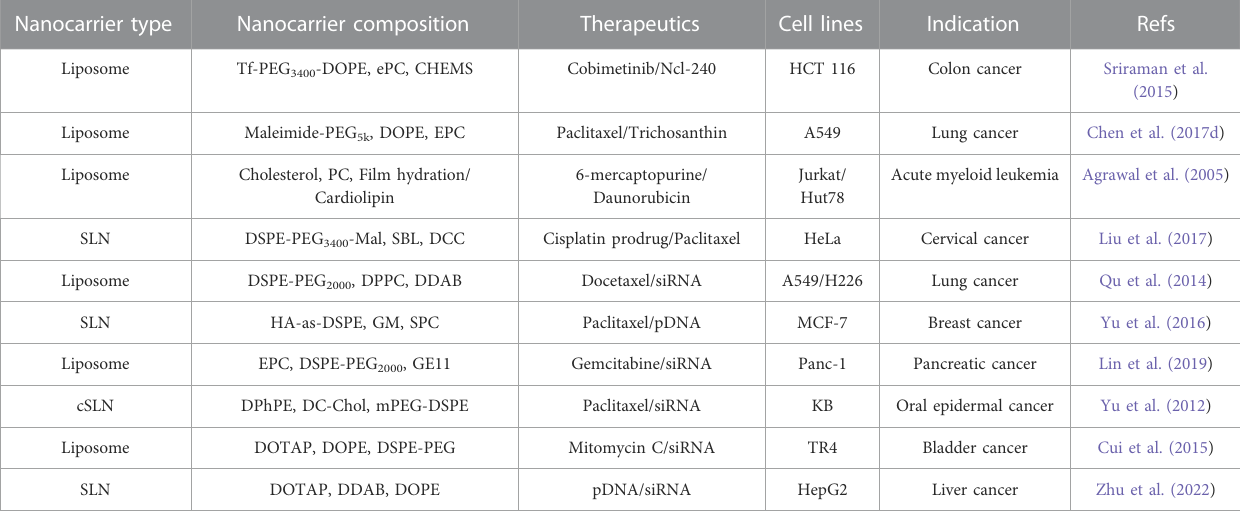
TABLE 1 Lipid-based nanocarriers for simultaneous delivery of therapeutics for cancer